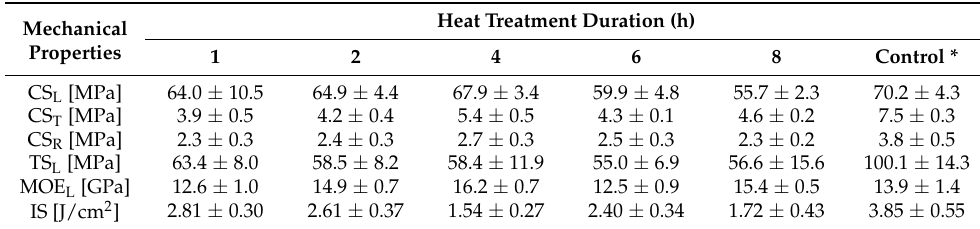
Table 3. Mechanical properties of wood.